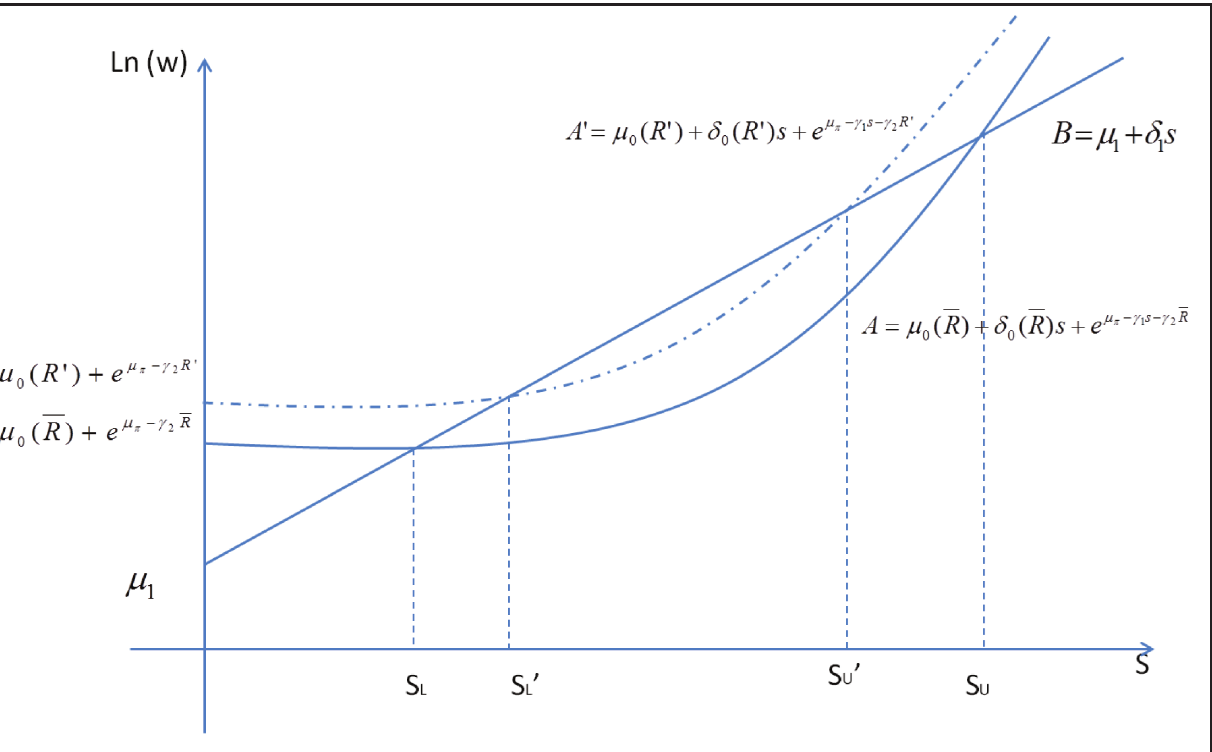
Figure 1 Migration selection, schooling, and